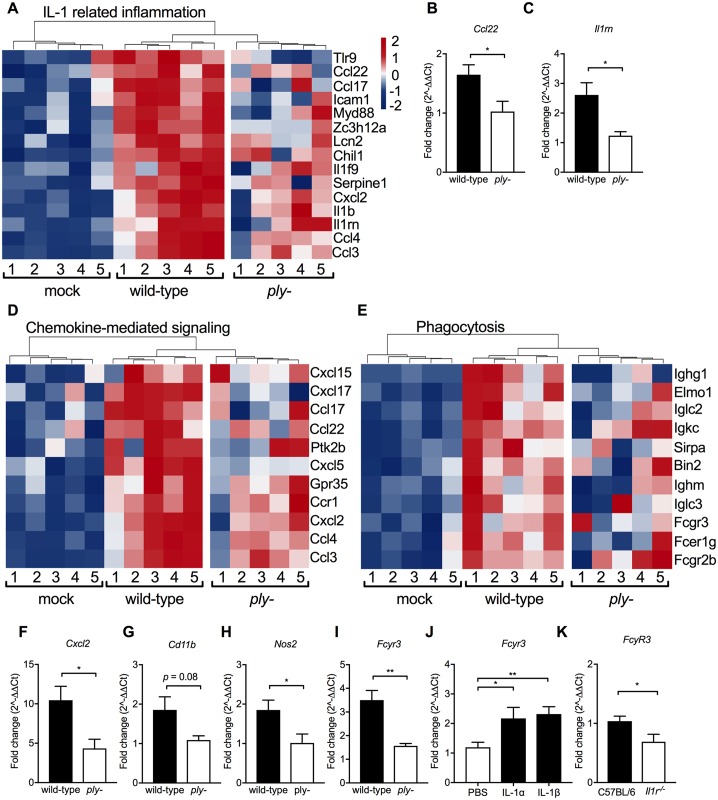
Pathways involved in clearance of pneumococcal colonization.At day 4 of life, pups were i.n. infected with serotype 23F wild-type or ply- and URT was lavaged with RLT to obtain RNA for RNA-seq comparisons. RNA-seq heatmaps show gene expression of the comparison wild-type colonized versus mock controls with relative gene expression in log2 fold change demonstrating increased expression in red and decreased expression in blue. Expression of these genes during ply- colonization is shown for comparison. (A) Heat-map illustrating gene expression in IL-1 related inflammation pathways. qRT-PCR was used to measure expression of (B) Ccl22 and (C) Il1rn that was calculated as fold-change compared to mock-challenged age-controlled animals. (D-E) Heatmaps showing go-term clusters (D) Chemokine-mediated signaling and (E) Phagocytosis that are significantly upregulated following pneumococcal colonization. qRT-PCR was used to measure expression of (F) Cxcl2, (G) Cd11b, (H), Nos2, and (I) Fcyr3 at 21 days post-inoculation. Fold-change compared to mock-challenged age-controlled animals. (J) Fold change in Fcyr3 expression in serotype 4 ply- colonized pups following IL-1α and IL-1β dosing as compared to PBS-treated control pups at 4 days post-challenge. (K) Fold change in Fcyr3 expression in 23F colonized C57BL6 and Il1r-/- pups at 21 days post-inoculation. Groups represent n = 7–11 animals with mean ±SEM. Significance is indicated by *, P < 0.05; **, P < 0.01.